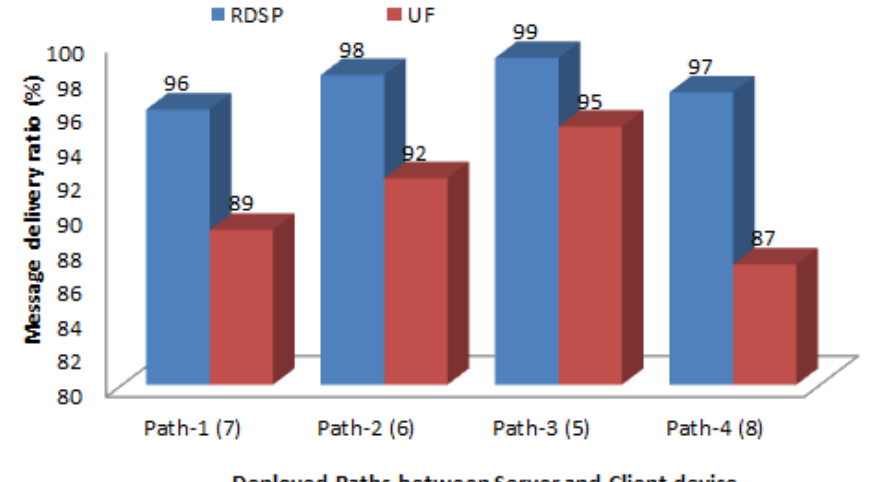
Figure 11. Message delivery ratio.